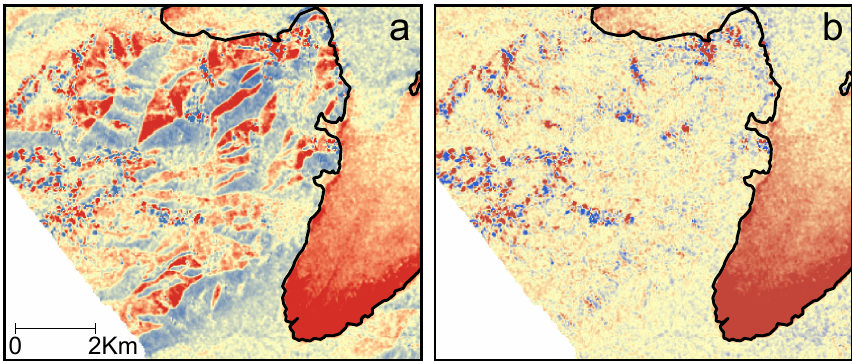
Fig. 3. Elevation differences estimated from DEM differencing before (a) and after the co-registration via a refined geocoding lookup table (b) . Location of the data example is shown in Fig.